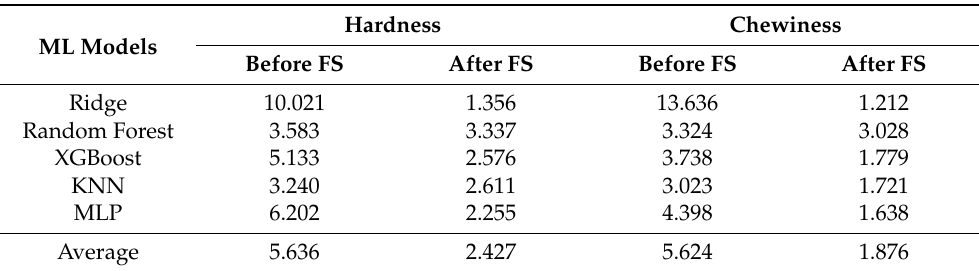
Table 3. Ratio of test/training RMSE scores across all models before and after feature selection for Hardness and